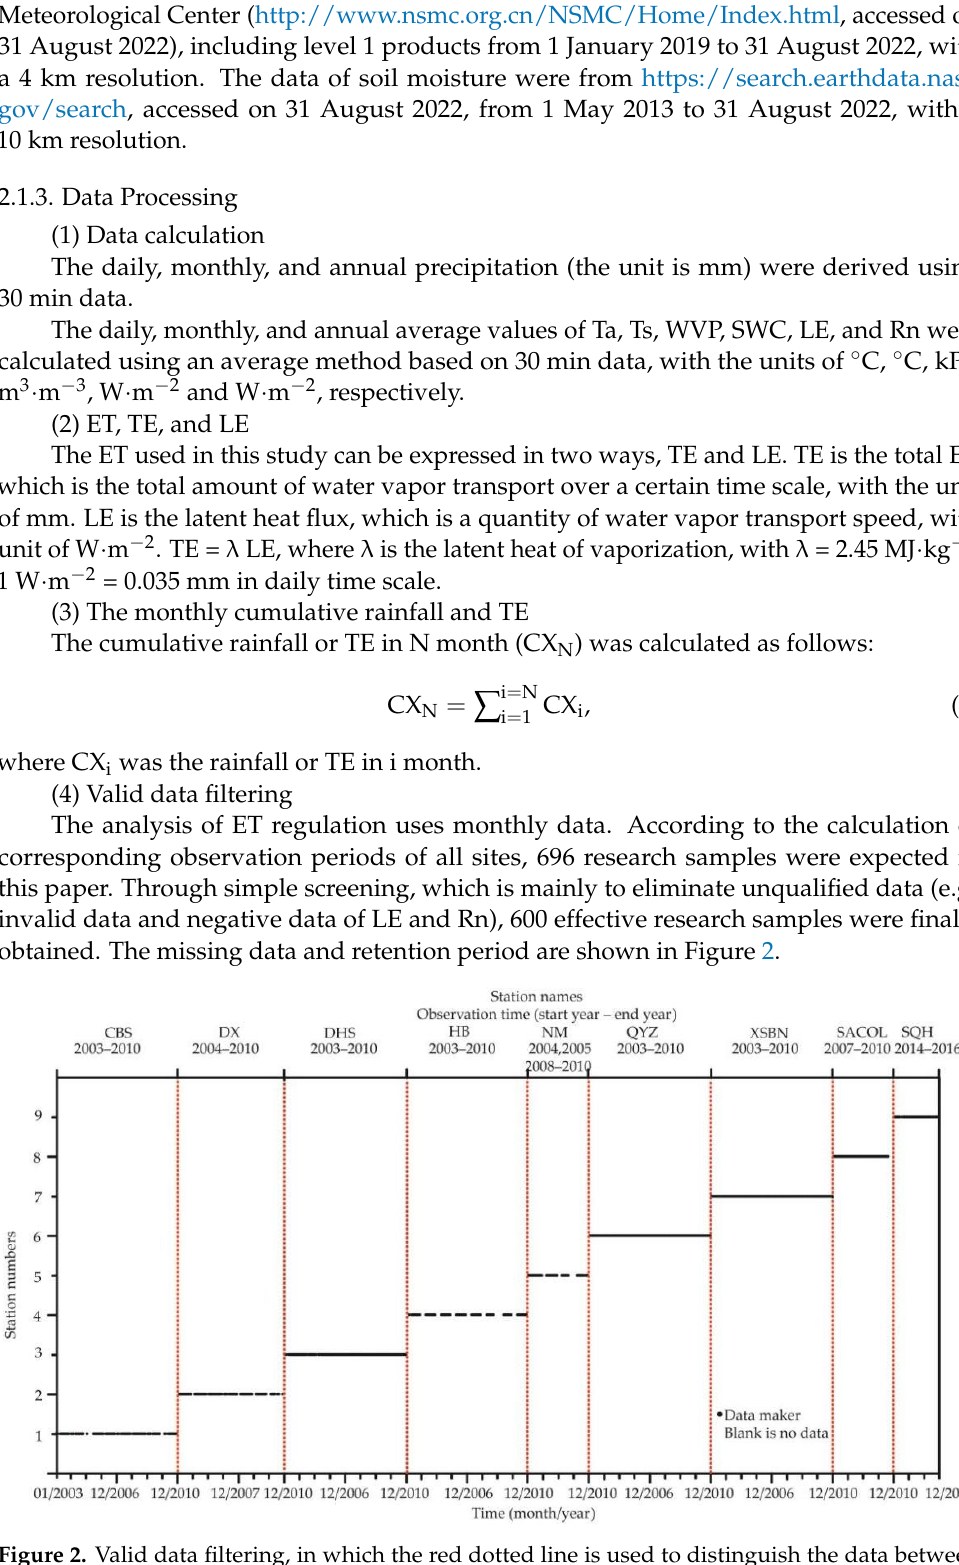
Figure 2. Valid data filtering, in which the red dotted line is used to distinguish the data between stations. In the lower abscissa, the interval between two scales is one year.